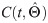
Model 2 output: (a) the best-fit solution obtained by fitting C(t,Θ^) (dashed curve) in system (1) to the cumulative number of H1N1 cases is displayed. (b) Dynamics of the media effect term (M(t) = d × m(t)) of Model 2 are displayed.